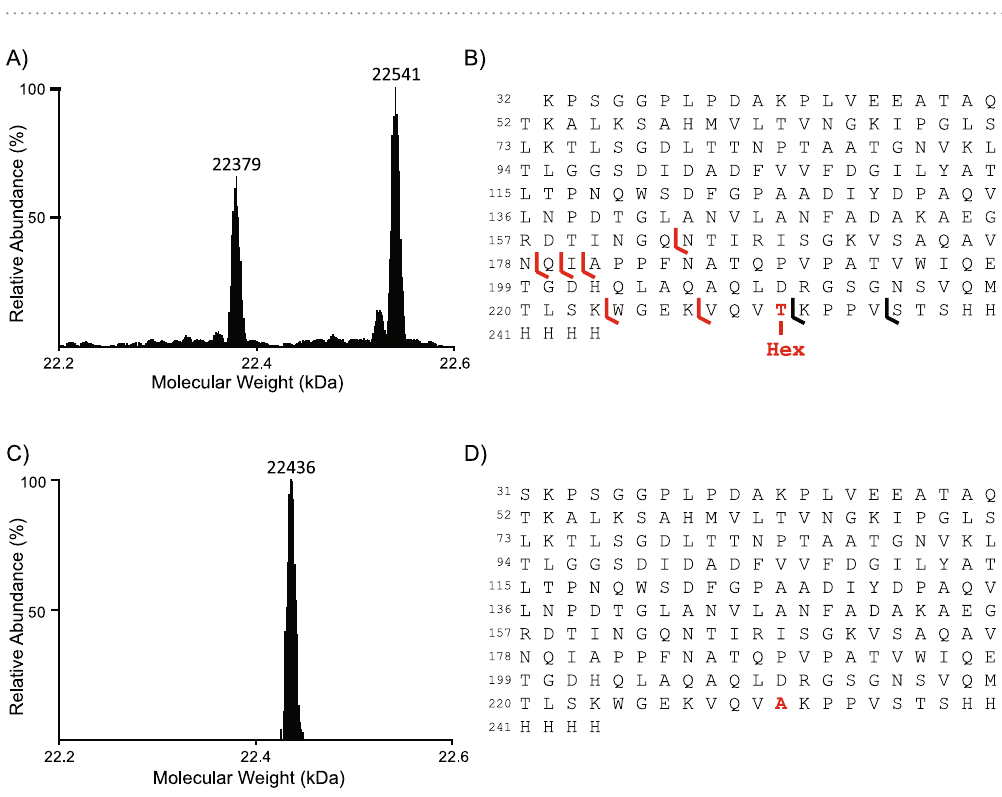
Figure 2. Impact of protein O -mannosylation on LAM exposition to the bacterial cell surface and release of the LprG/LAM complex. ( A ) FACS analyses of LAM staining on the surface of the various M . tuberculosis strains. The bar graph values correspond to the median fluorescence value after normalization to H37Rv. Results are representative of two independent experiments. * P < 0.05. ( B ) Western-blot analyses of LAM associated with LprG in WT M . tuberculosis or Δ pmt mutant. Similar amounts of LprG-His protein purified from the bacteria or culture medium were separated by SDS-PAGE. After transfer, the LAM or LprG-His molecules were revealed using the anti-LAM antibody CS-35 or an anti-His antibody. Blots are representative of at least three independent experiments.